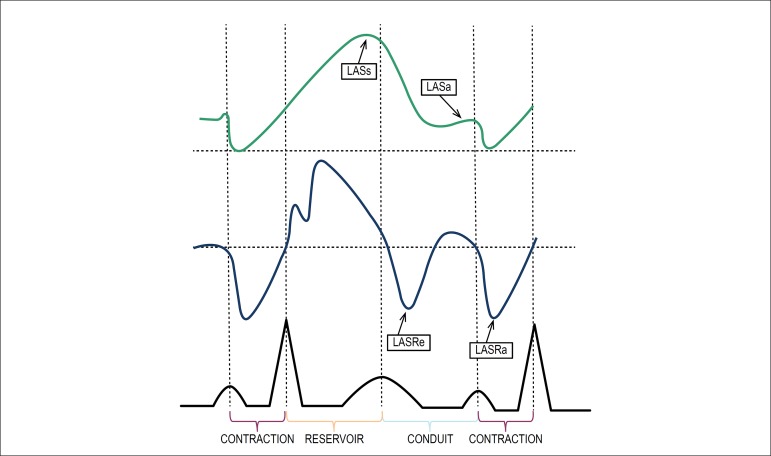
Left atrial phasic functions and their relationship with the cardiac
cycle. Strain and strain rate curves are shown. During left
ventricular (LV) systole and isovolumetric relaxation, left atrium
(LA) works as a distensible reservoir accommodating blood flow from
the pulmonary veins. During early LV diastole, LA behaves as a
conduit that starts with mitral valve opening and terminates before
LA contraction, allowing passive emptying during early ventricular
diastole and diastasis. Finally, at end-diastole, LA acts as a
muscular pump contributing to LV filling with active atrial
contraction. (LASs: left atrial systolic strain; LASa: left atrial
diastolic strain; LASRe: early left atrial strain rate; LASRa: late
left atrial strain rate).